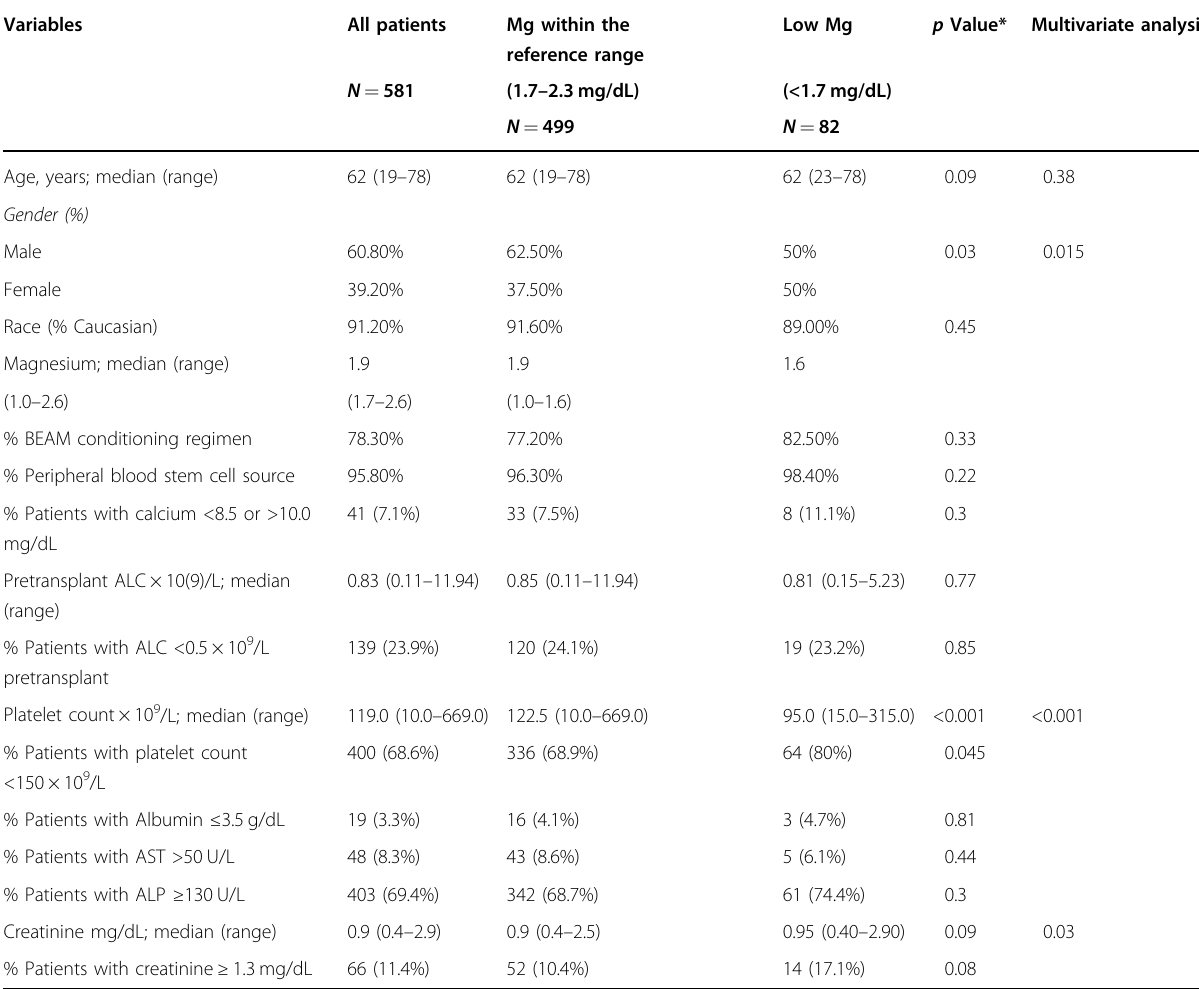
Table 1 Pretransplant laboratory values in all patients and by normal or low pretreatment serum magnesium level